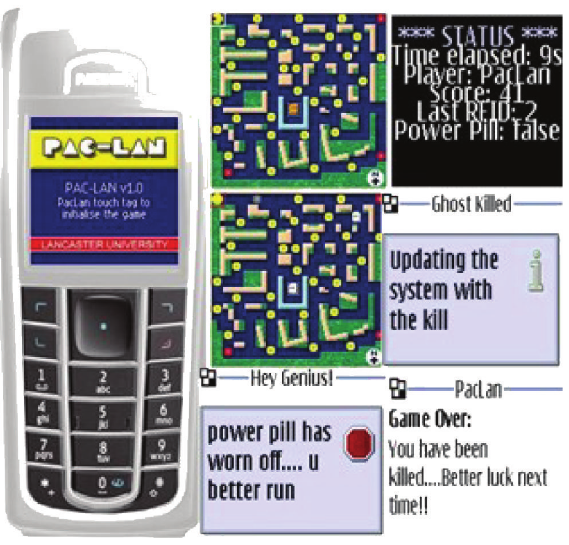
Figure 2: PAC-LAN